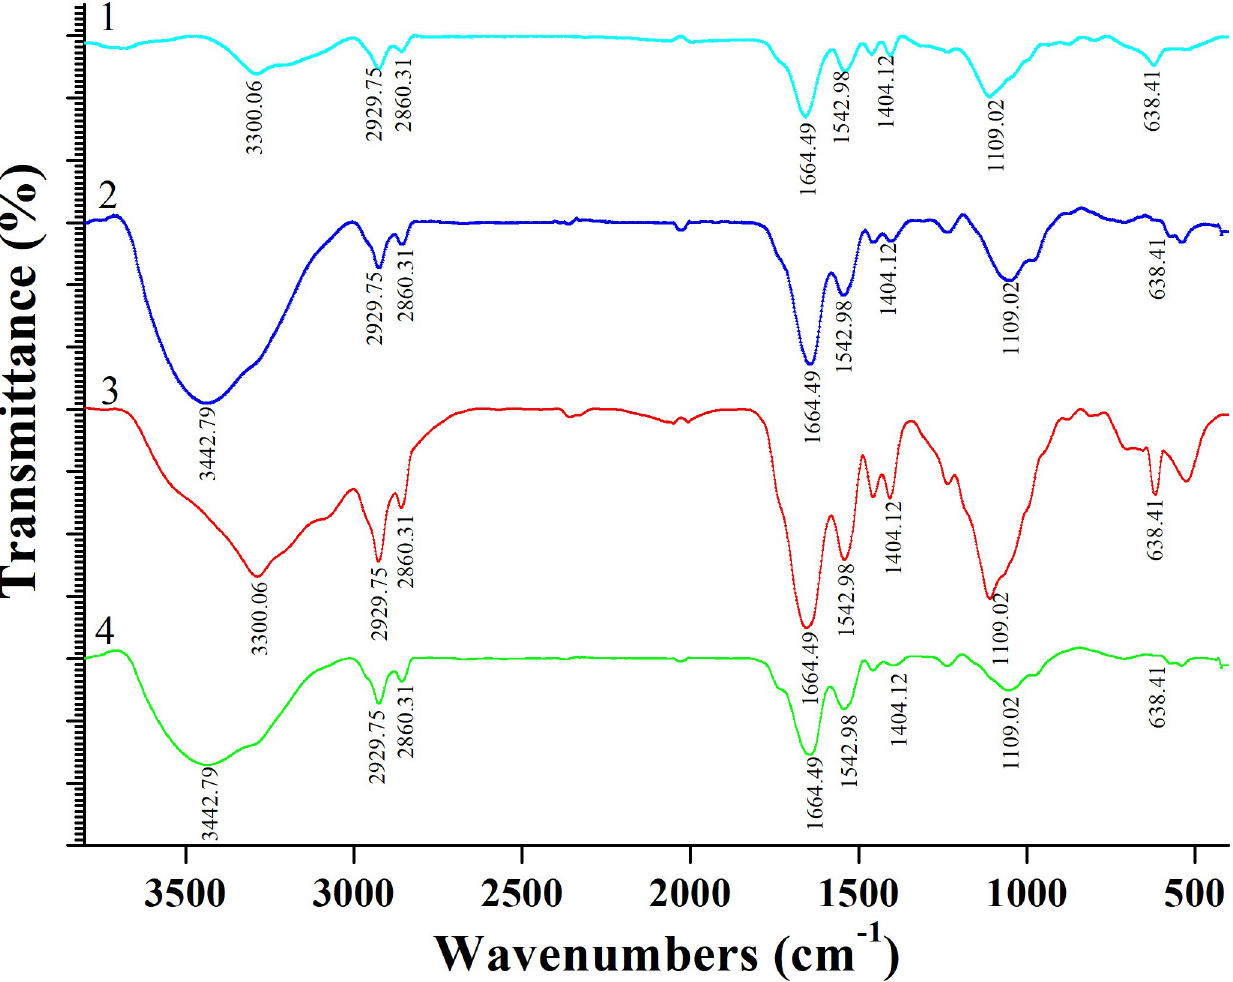
Fig 6. FT-IR spectrum of live and dead biosorbents loaded with and without Pb 2+ (1: Native live biosorbents; 2: Pb 2+ loaded live biosorbents; 3: Nativedead biosorbents; 4: Pb 2+ loaded dead biosorbents; Pb 2+ : 200 mg L -1 ).